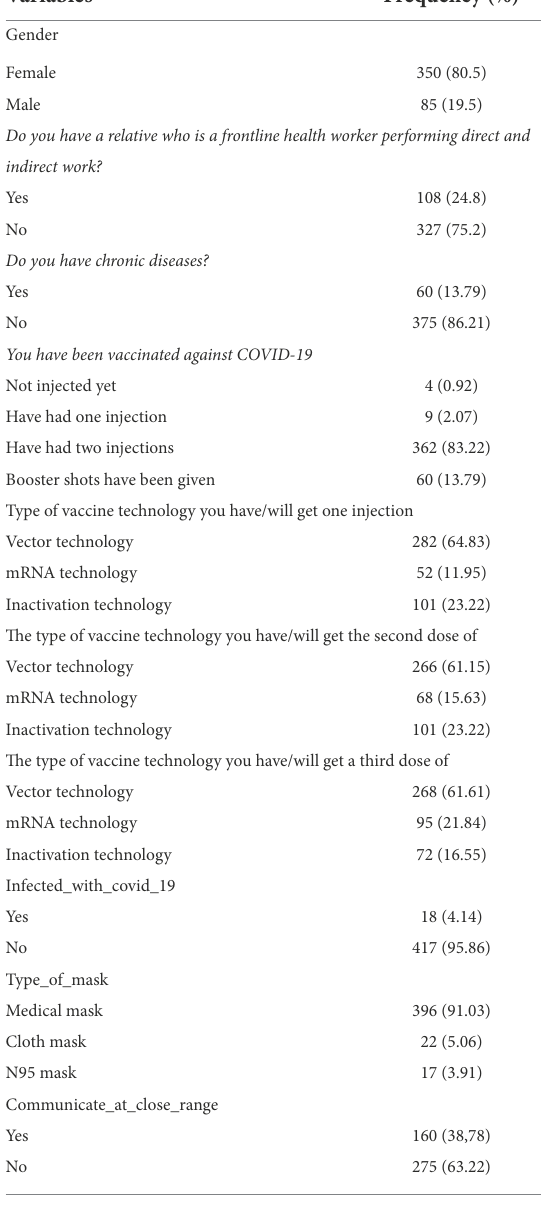
TABLE 1 Sample socio-demographic